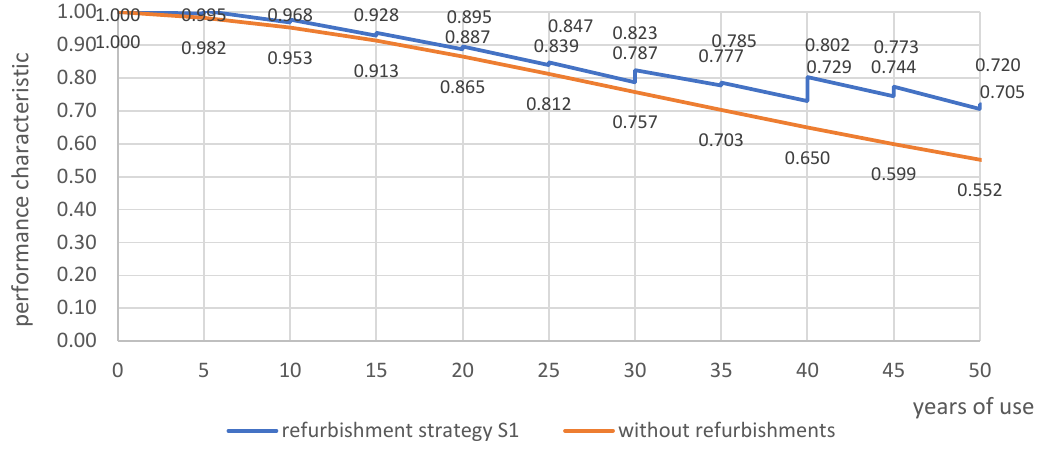
Figure 1. Prediction of changes in the technical condition of a building refurbished according to S1 strategy and a building without refurbishment.